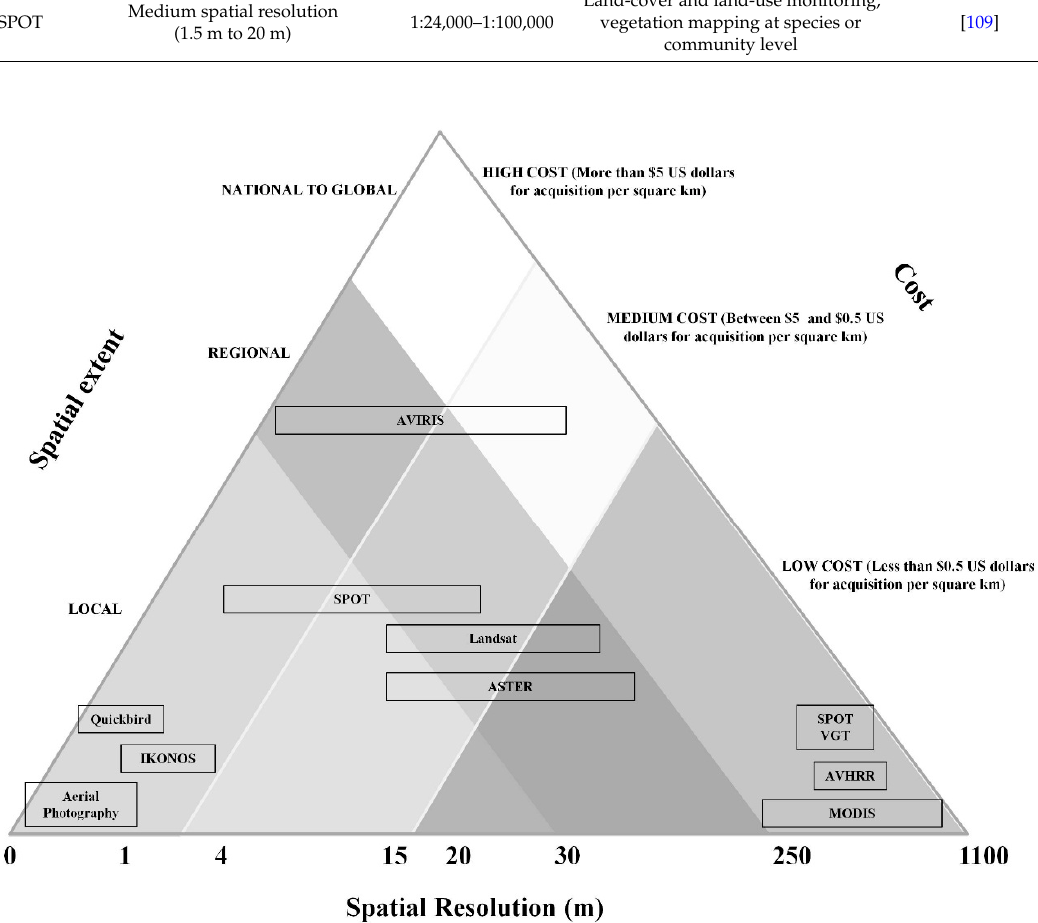
Figure 1. Satellite sensors commonly used for mapping and monitoring of GDEs.